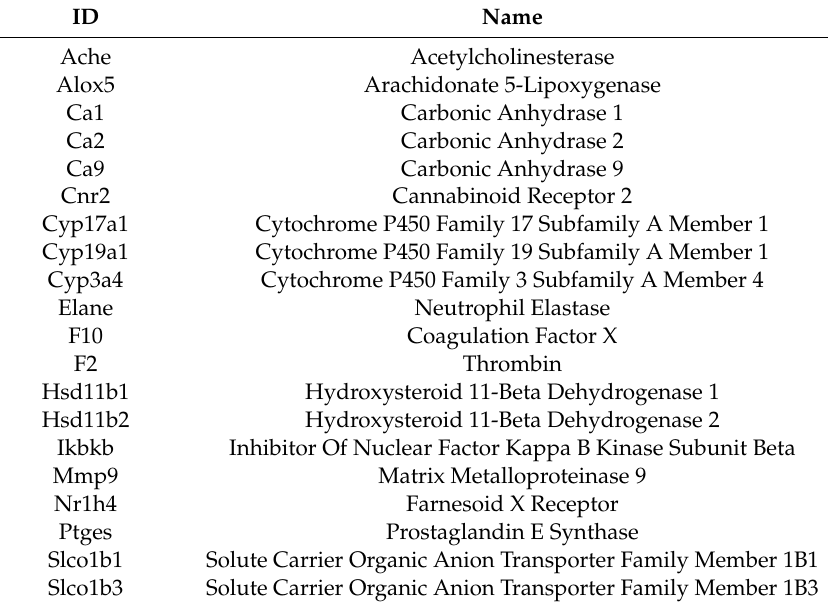
Table 2. Predicted probable primary targets of compound